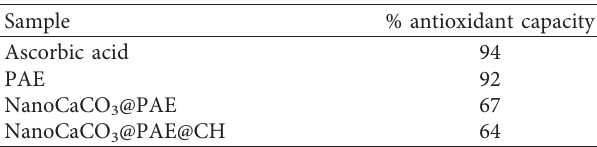
Table 2: Percentages of antioxidant capacity by spectrophoto- metric DPPH assay testing samples at 3mg/ml of PAE; data have been obtained from average of three